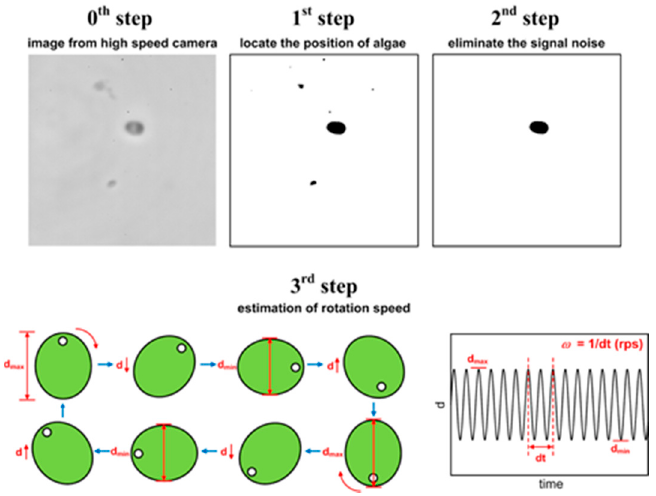
Figure 2. Image processing for quantifying the rotational speed of the cell.